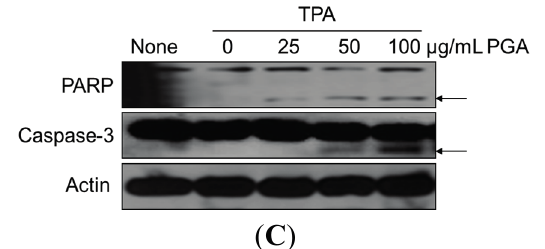
Figure 2. Effect of PGA on apoptosis in TPA-induced HT-29 cells. Cells were treated with 100 nM 12- O -tetradecanoylphorbol-13-acetate (TPA), alone or in combination with PGA, at 25, 50, 100 μ g/mL for 48 h, and then apoptosis was measured by TUNEL assay ( A ) Scale bar = 20 µm; Under the same condition, apoptosis was also measured by Annexin V staining, and quantitative analysis of the percentage of total apoptotic cells was represented by graphs ( B ); Cells were treated with 12- O -tetradecanoylphorbol-13-acetate (TPA), and different concentrations of PGA at 25, 50, 100 μ g/mL for 24 h, and then PARP and caspase-3 were measured by Western blot analysis ( C ). Data are expressed as mean ± SD. * p < 0.05 vs. TPA alone.